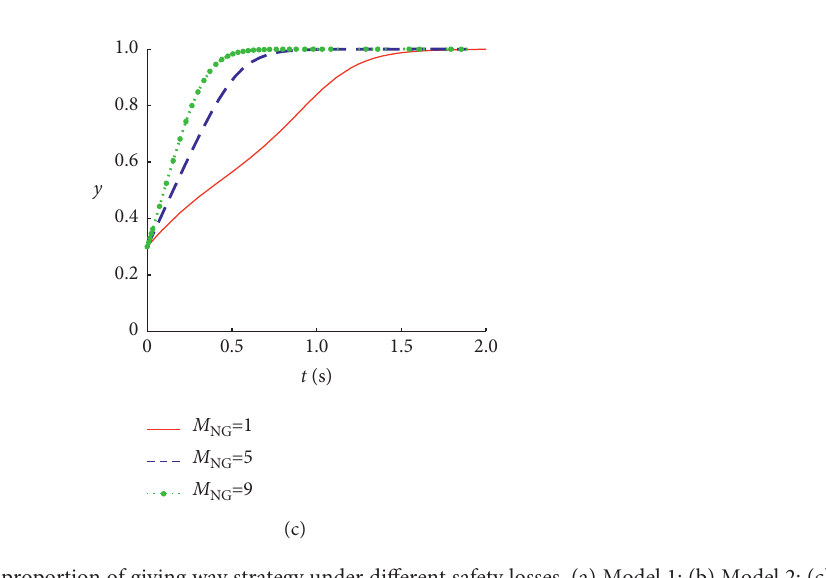
Figure 3: Evolutionary paths of the proportion of giving way strategy under different safety losses. (a) Model 1; (b) Model 2; (c) Model